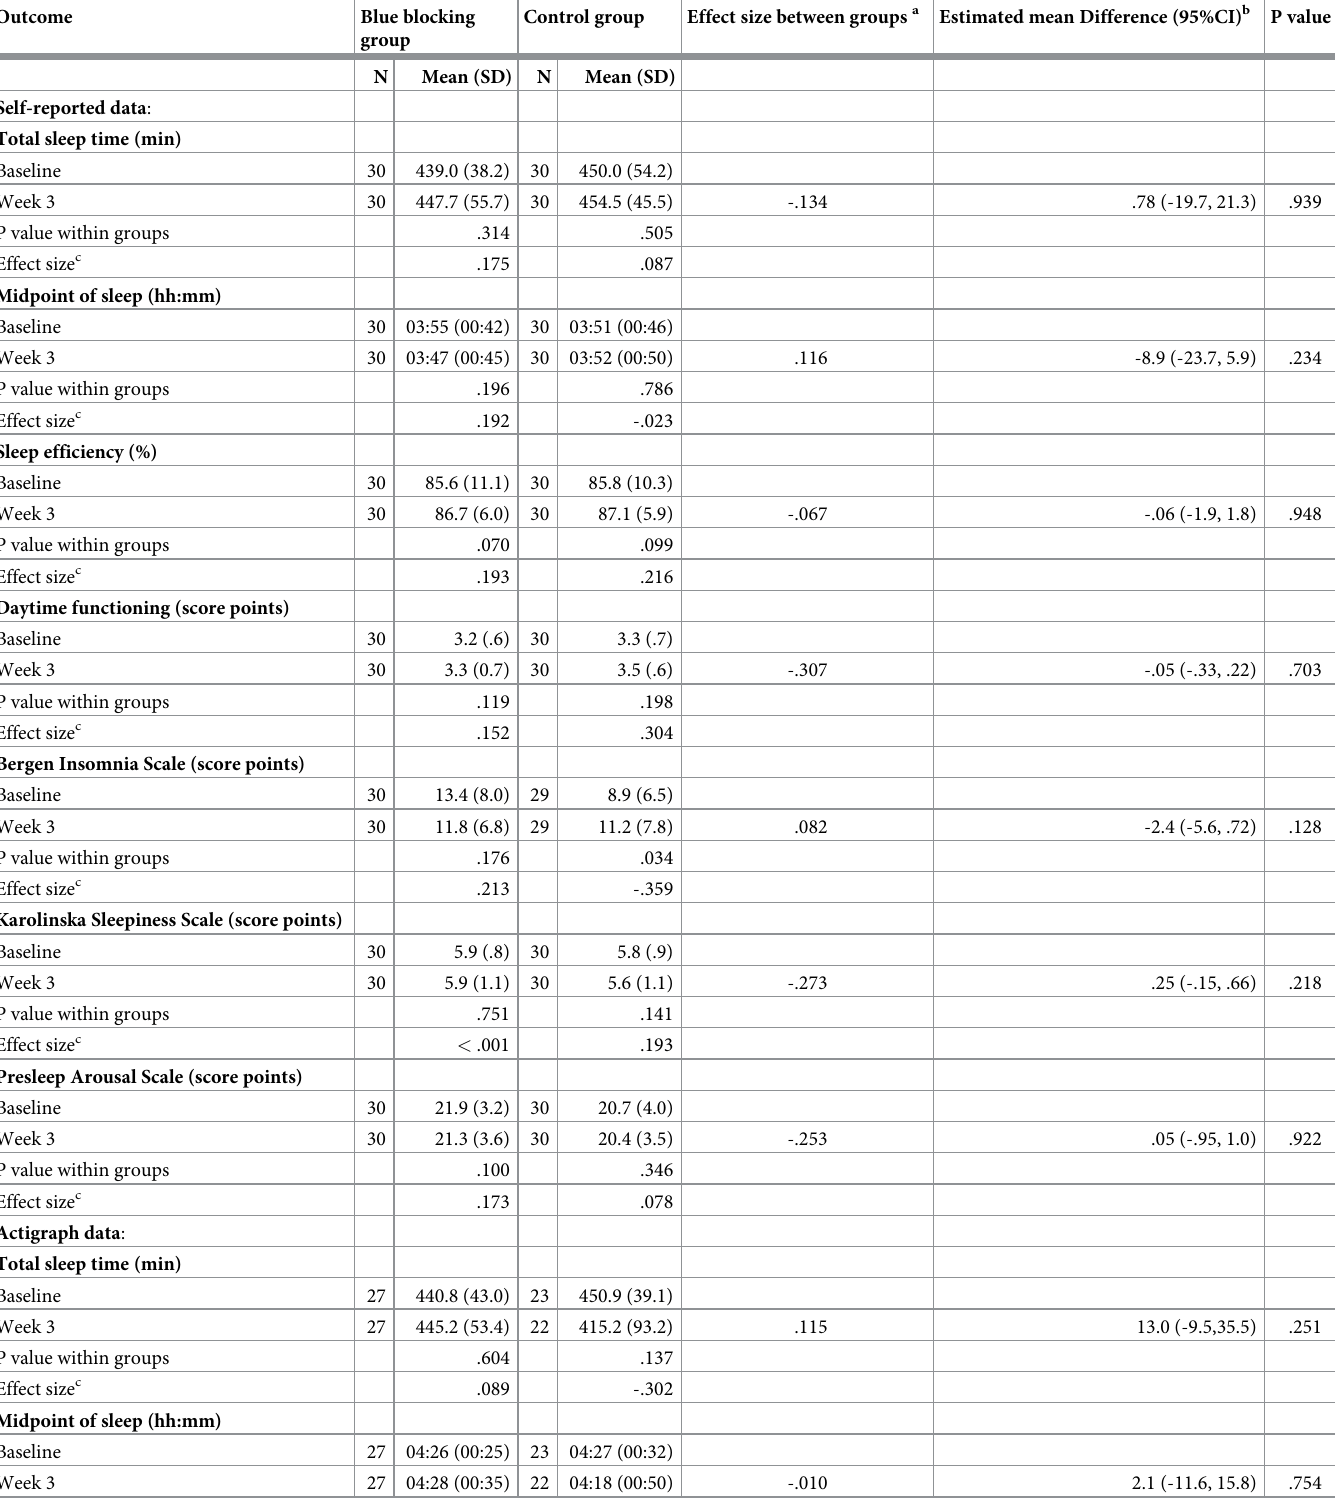
Table 2. Outcome at